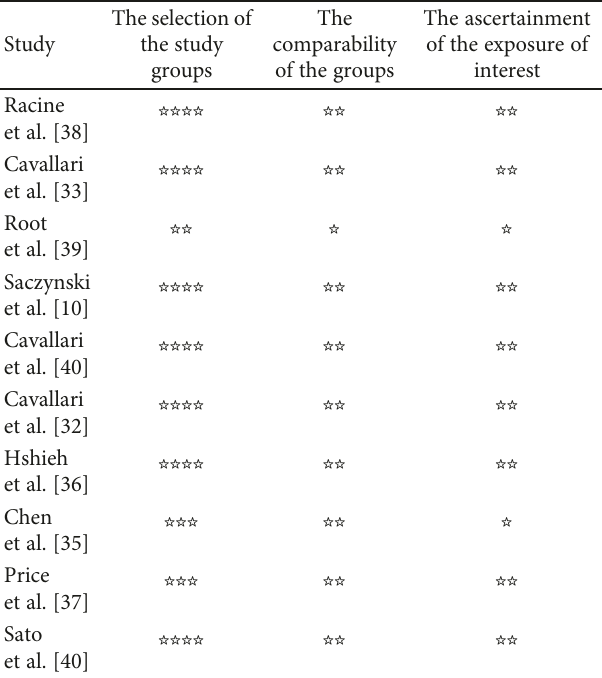
Table 4: Newcastle Ottawa Scale of included